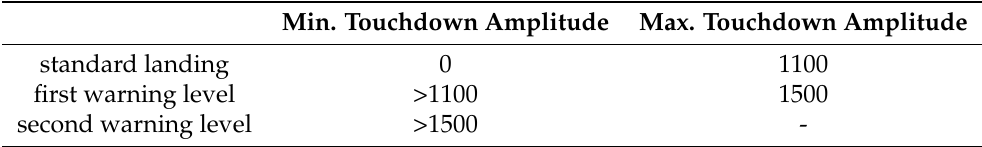
Figure 10. An example of flight records with simulated landing approaches: ( a ) strain on landing gear attachment node with indication of take-off and full stop landing; ( b ) altitude (barometric). Table 3. Warning levels for maximum strain amplitude [ µ Str] during aircraft